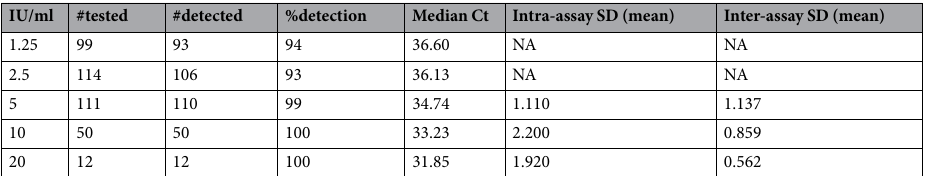
Table 1. Limit of detection and reproducibility on low copy dilutions of the WHO HDV standard. Sensitivity was determined by diluting the WHO HDV standard diluted in in HBV/HDV negative human plasma to the indicated IU/ml. Dilutions were tested at the indicated number of replicates; percent detection was determined based on the number of replicates detected. Reproducibility was evaluated for concentrations above the determined LOD; shown are the median Ct, average intra-assay standard deviation (SD) of Ct values, and inter- assay SD of Ct